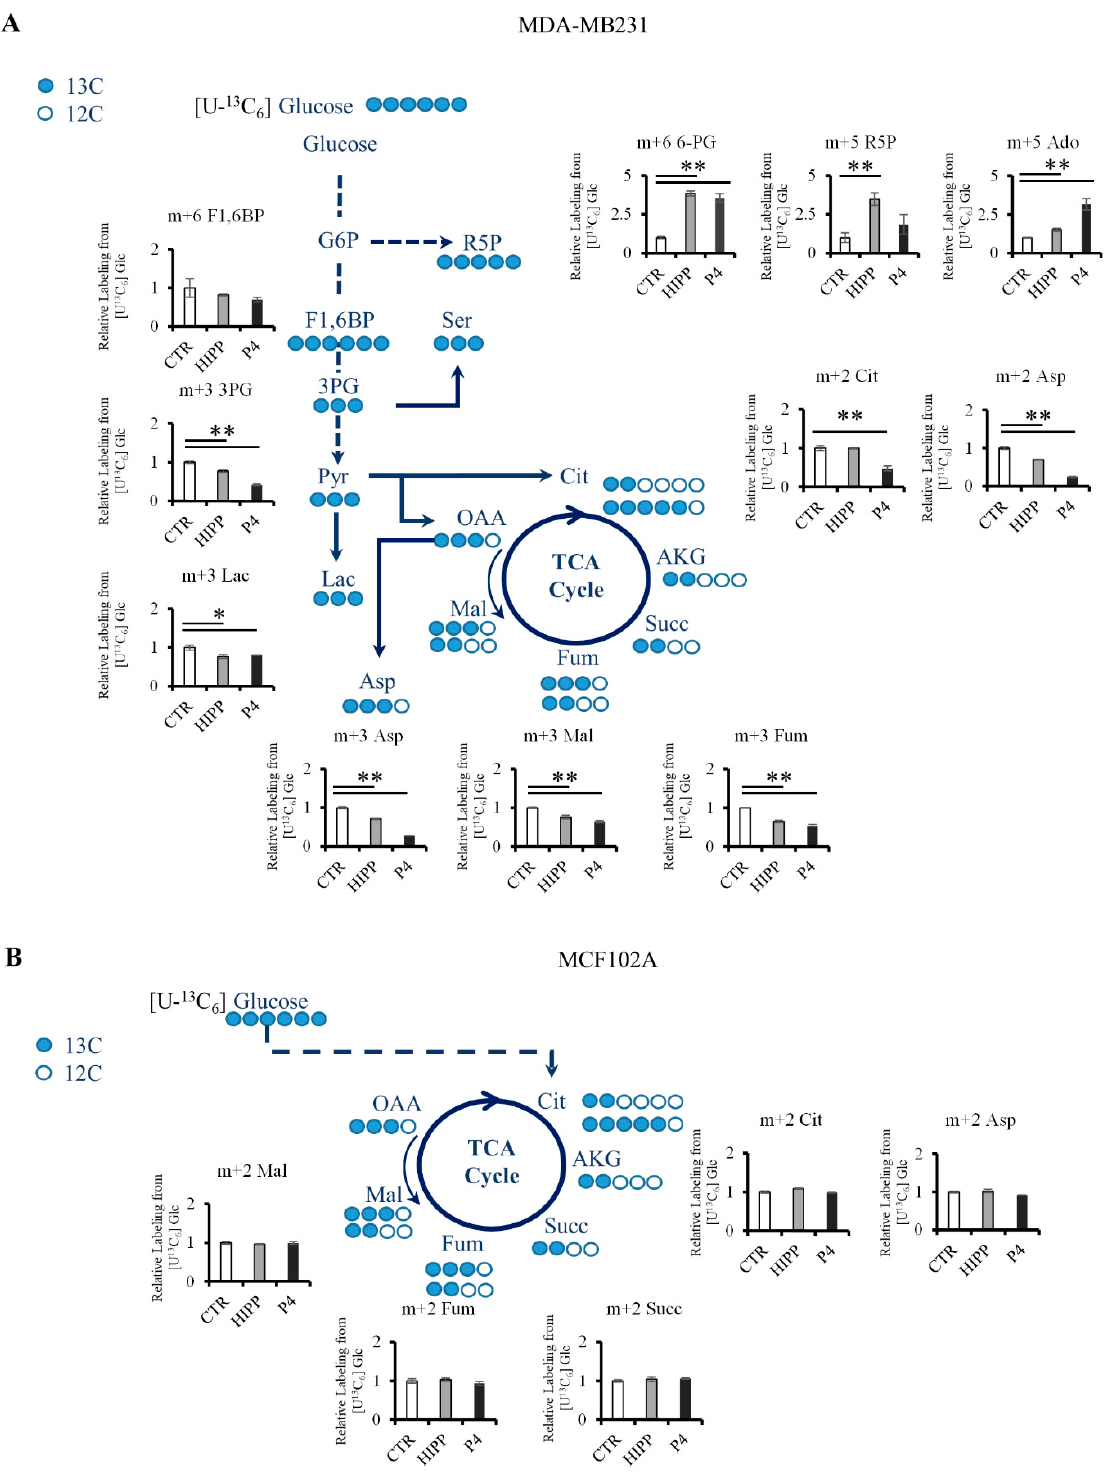
Figure 6. Glucose metabolic rewiring by (U- 13 C 6 ) glucose labeling. ( A,B ) Atom transition map of (U- 13 C 6 ) glucose (blue circles) used to detect metabolic changes of control or drug-treated MDA-MB231 ( A ) or MCF102A ( B ). Filled circles indicate 13C enrichment. ** p -value < 0.005; * p -value < 0.01 .